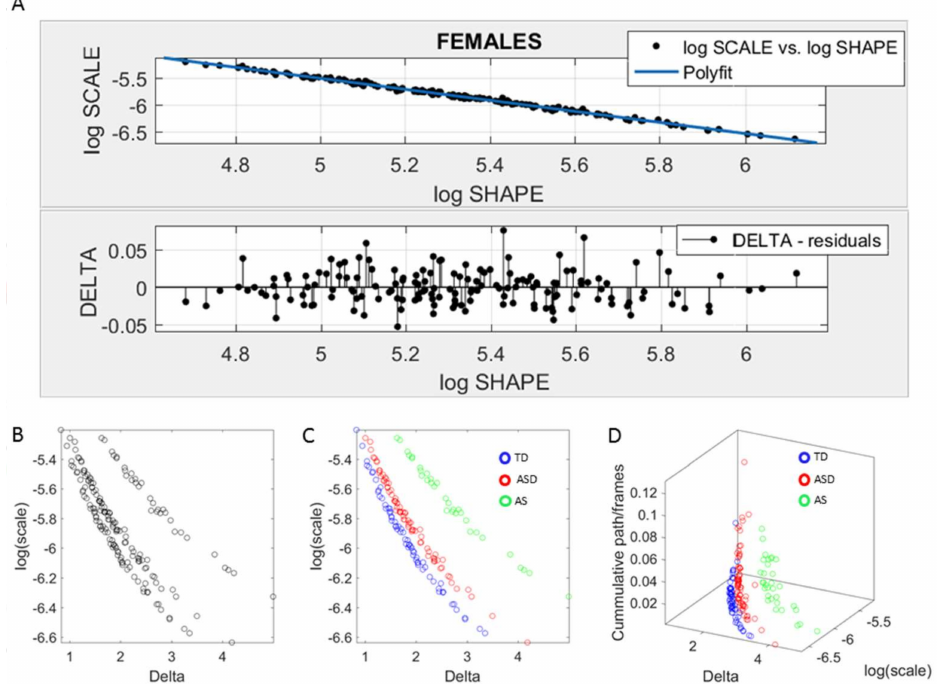
Figure A3. Taken from [24]. Characterizing the female phenotype with ASD and Asperger’s (AS) syndrome. ( a ) Line fit to the log–log Gamma parameter plane and delta-residuals. ( b ) Blind characterization of females according to delta residual from linear polynomial fit of the log–log scatter and the log of the estimated Gamma scale (noise to signal ratio). ( c ) The labels from the clinical data informing who is ASD or AS or typically developing (TD) separate the scatter according to the Diagnostics Statistical Manual, DSM-criteria. ( d ) Additional dimension on the z -axis denoting the cumulative path length of the head excursions across the full resting state time (300 frames at one hertz, i.e., five minutes trying to remain still but having too much involuntary head motions polluting their motor control.) Data from the Autism Brain Imaging Data Exchange (ABIDE I and II) repository (comprising over 2500 records with approximately one-fifth